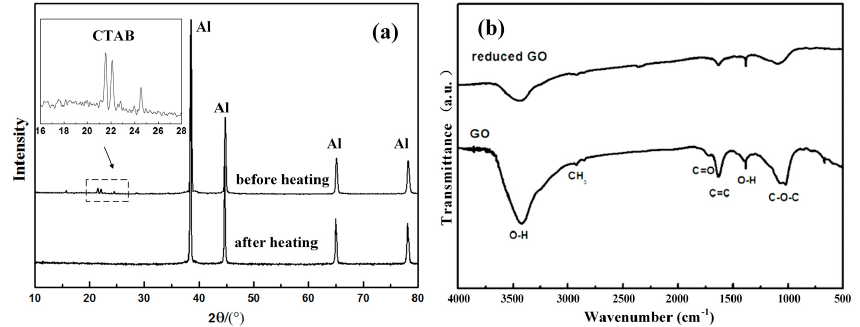
Figure 7. ( a ) XRD patterns for the composite powders before and after heating; and ( b ) FTIR spectra of GO and rGO after thermal reduction.